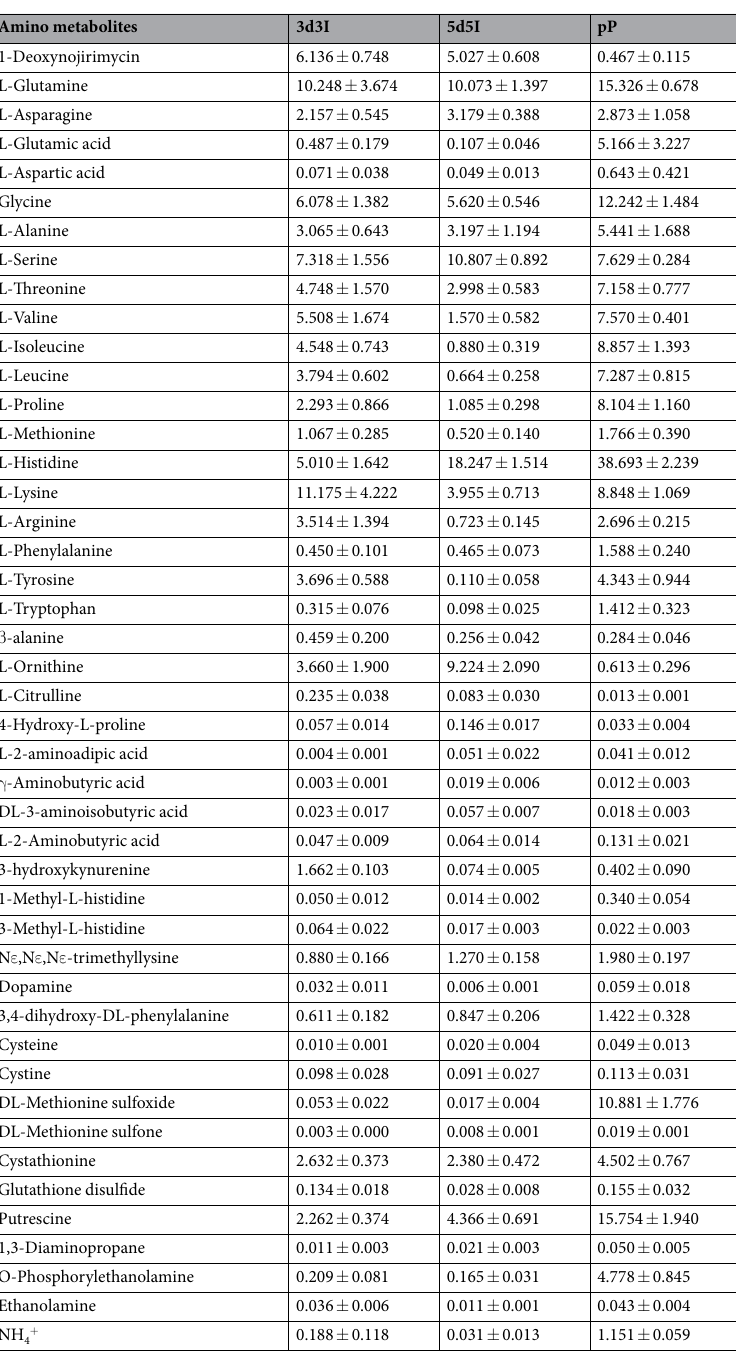
Table 3. Concentration of amino metabolites (mM) in haemolymph of silkworm ( Bombyx mori L strain P50) (the first number denotes day and second one instars, e.g, 5d5I: day 5 in the fifth instar; pP: